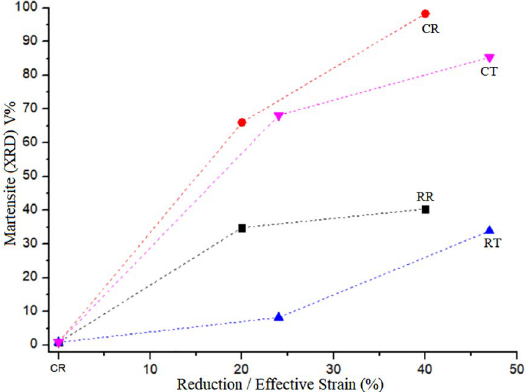
Figure 5. Induced martensitic transformation by rolling and tensile test at 298 K and 155